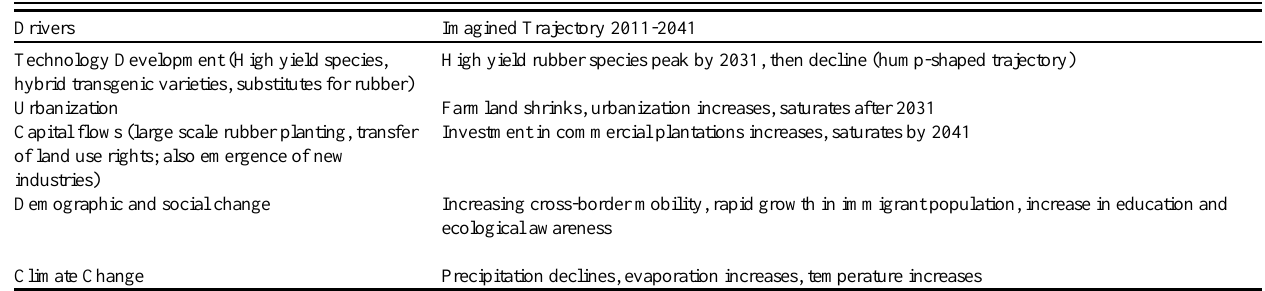
Table 2 . Example of specific scenario framework. Source: After Xishuangbanna Group 2 in Foran et al.